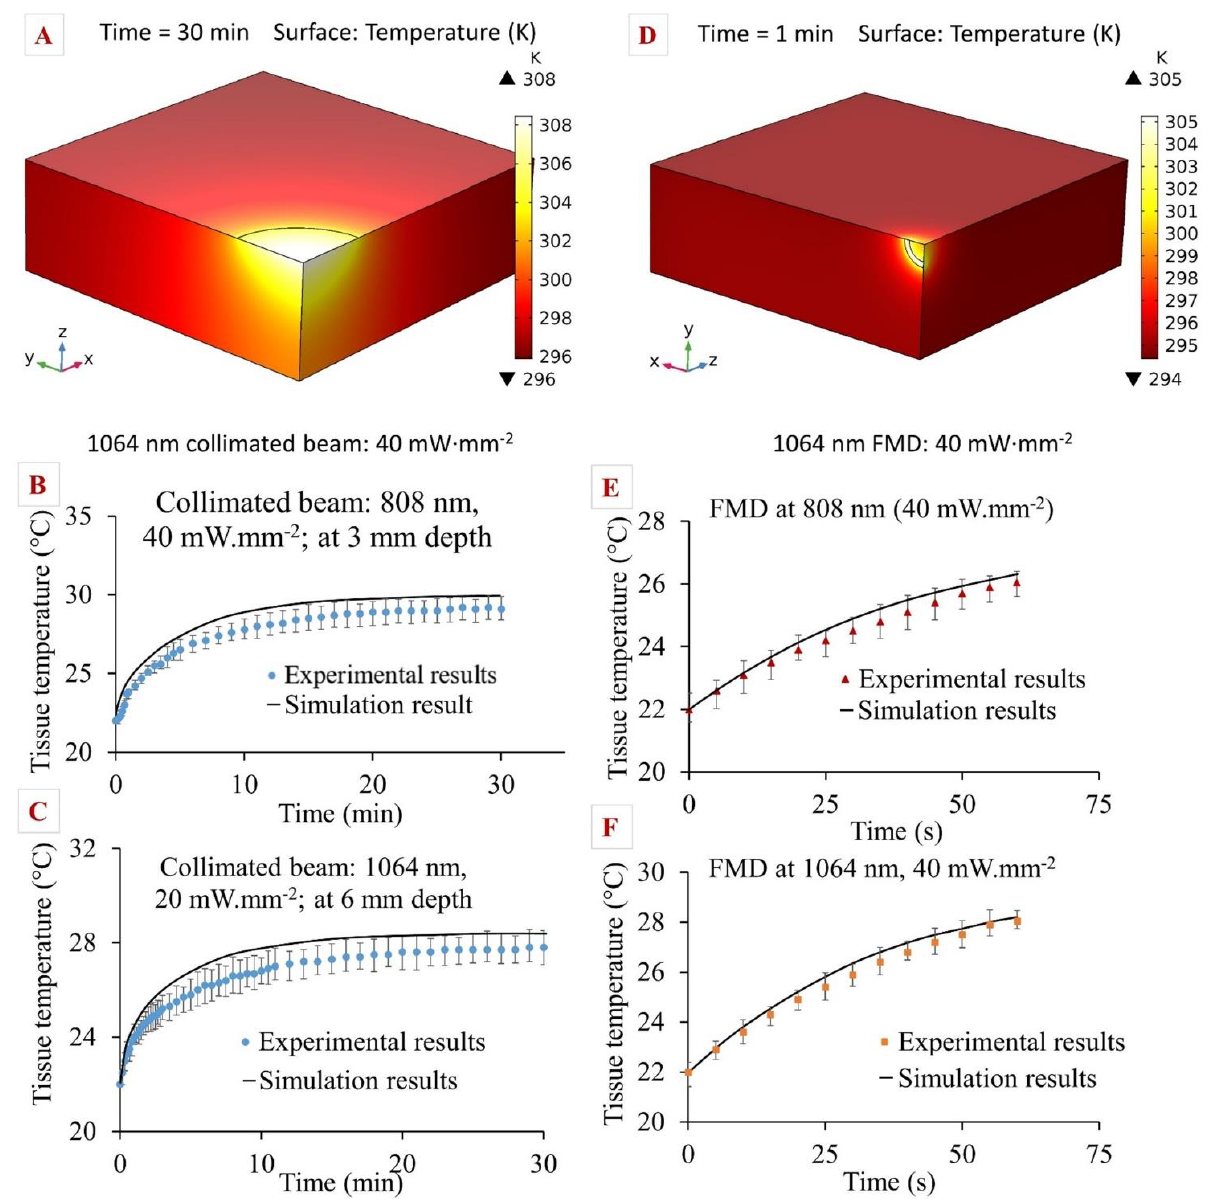
Figure 9. ( A ) Simulation results after 20 min of tissue photothermal heating by an 808 nm collimated beam with irradiance of 40 mW · mm − 2 ; comparison between simulation and experimental results for collimated beams at ( B ) 808 nm, 40 mW · mm − 2 irradiance, 3 mm tissue depth; ( C ) 1064 nm, 20 mW · mm − 2 irradiance at 6 mm tissue depth; ( D ) simulation results after 1 min of tissue photothermal heating by FMD at 1064 nm, 40 mW · mm − 2 irradiance; comparison of simulation and experimental results for FMD at ( E ) 808 nm, 40 mW · mm − 2 ; ( F ) 1064 nm, 40 mW · mm − 2 irradiances. Error bars represent mean ± 1 σ (standard deviation) for n = 5 trials.